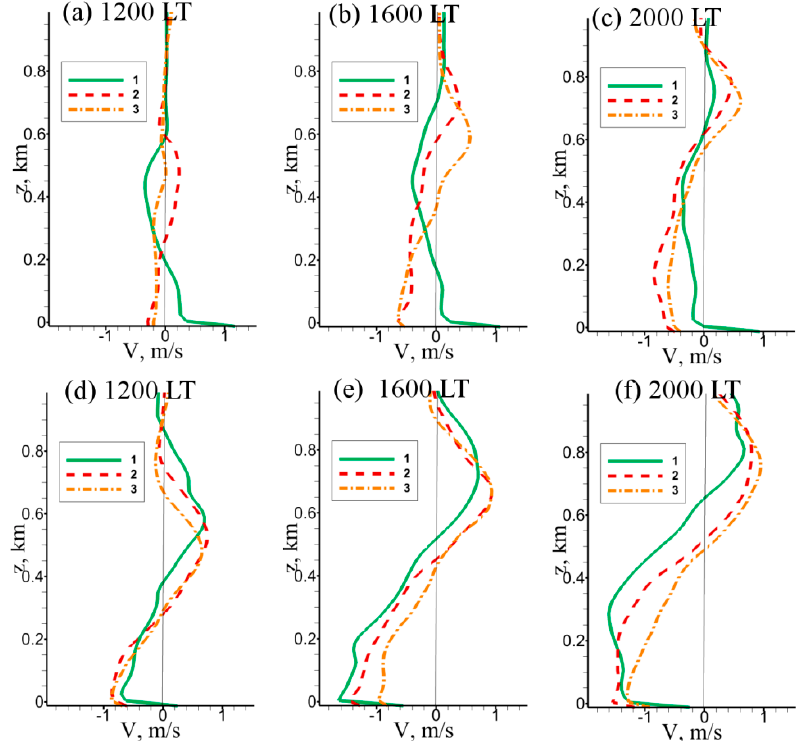
Figure 10. Vertical profiles of horizontal velocity ( y -component), averaged over the cross-sections (along the lines 1, 2, 3 indicated in Figure 2a), at different diurnal phases. ( a – c ) Summer case; ( d – f ) Winter case.